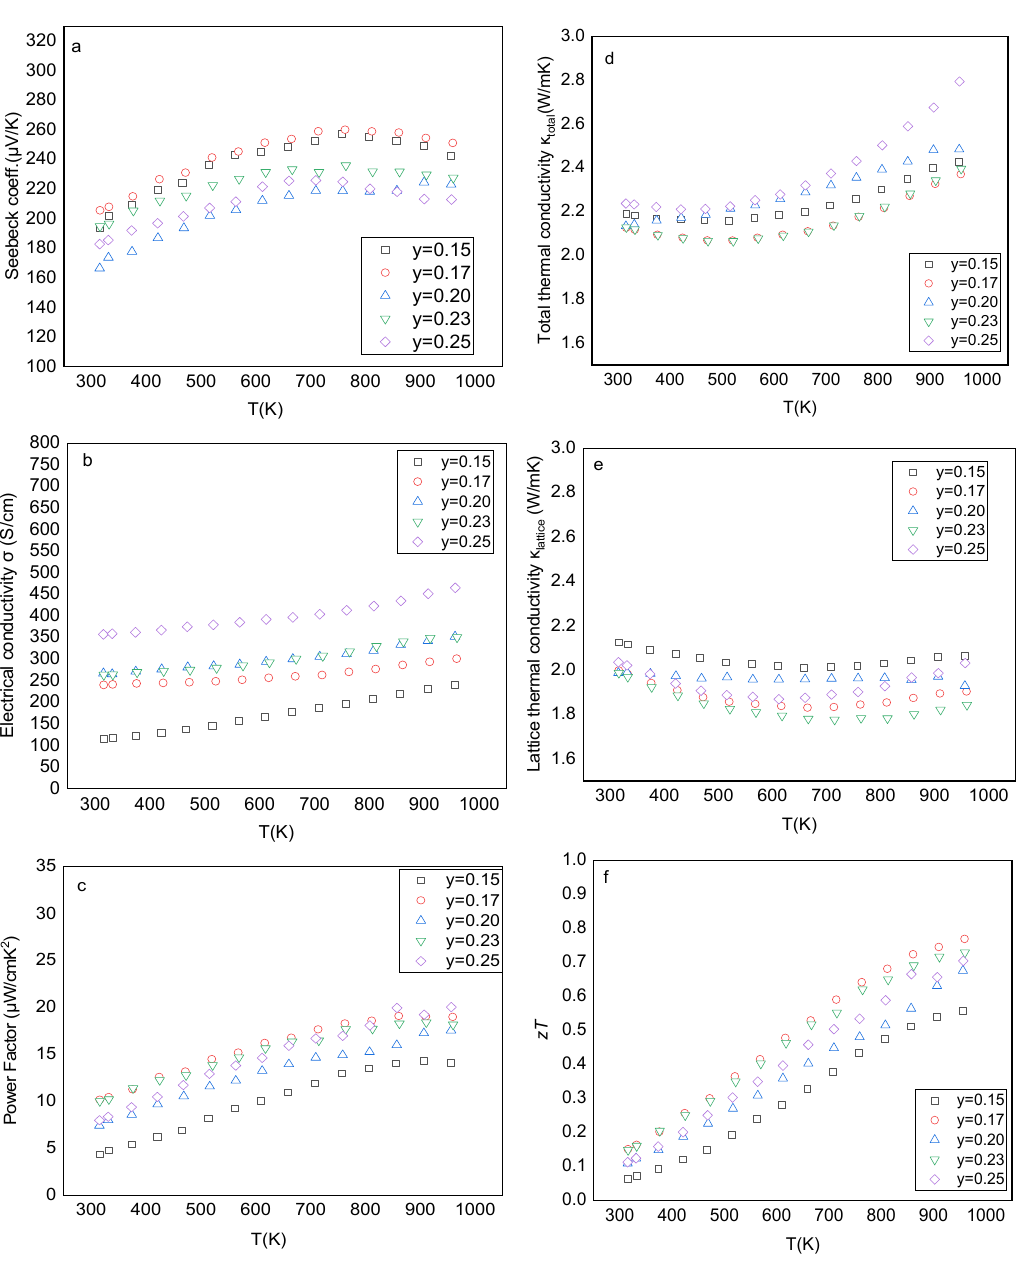
( c ), total thermal conductivity ( d ), lattice thermal conductivity ( e ) and thermoelectric figure-of-merit